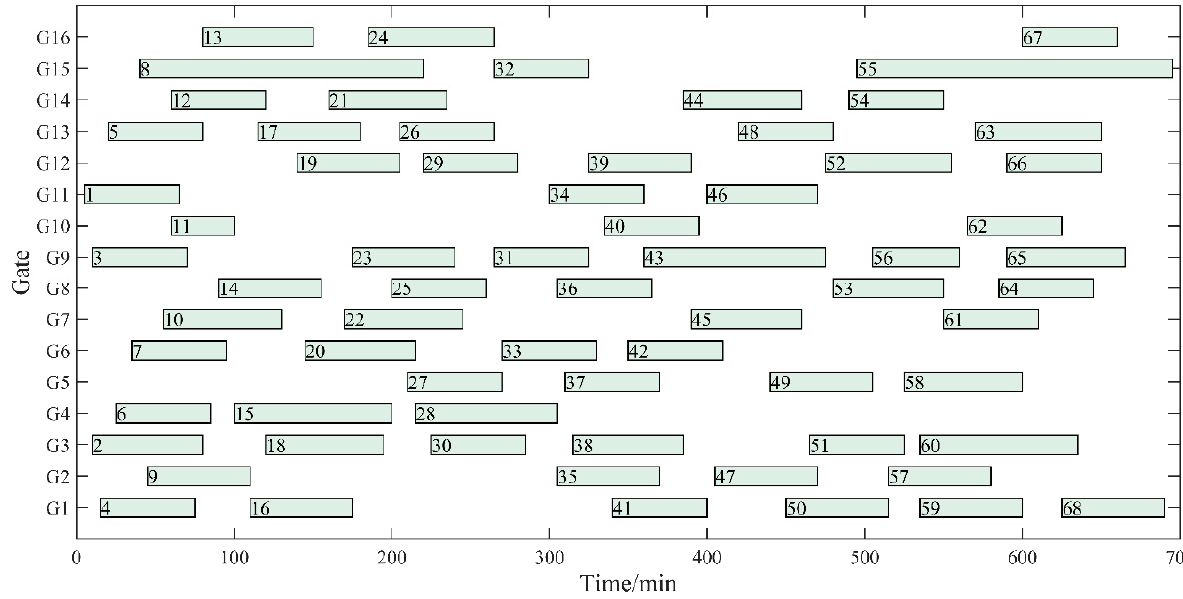
Figure 5. Gantt chart of the original gate assignment.